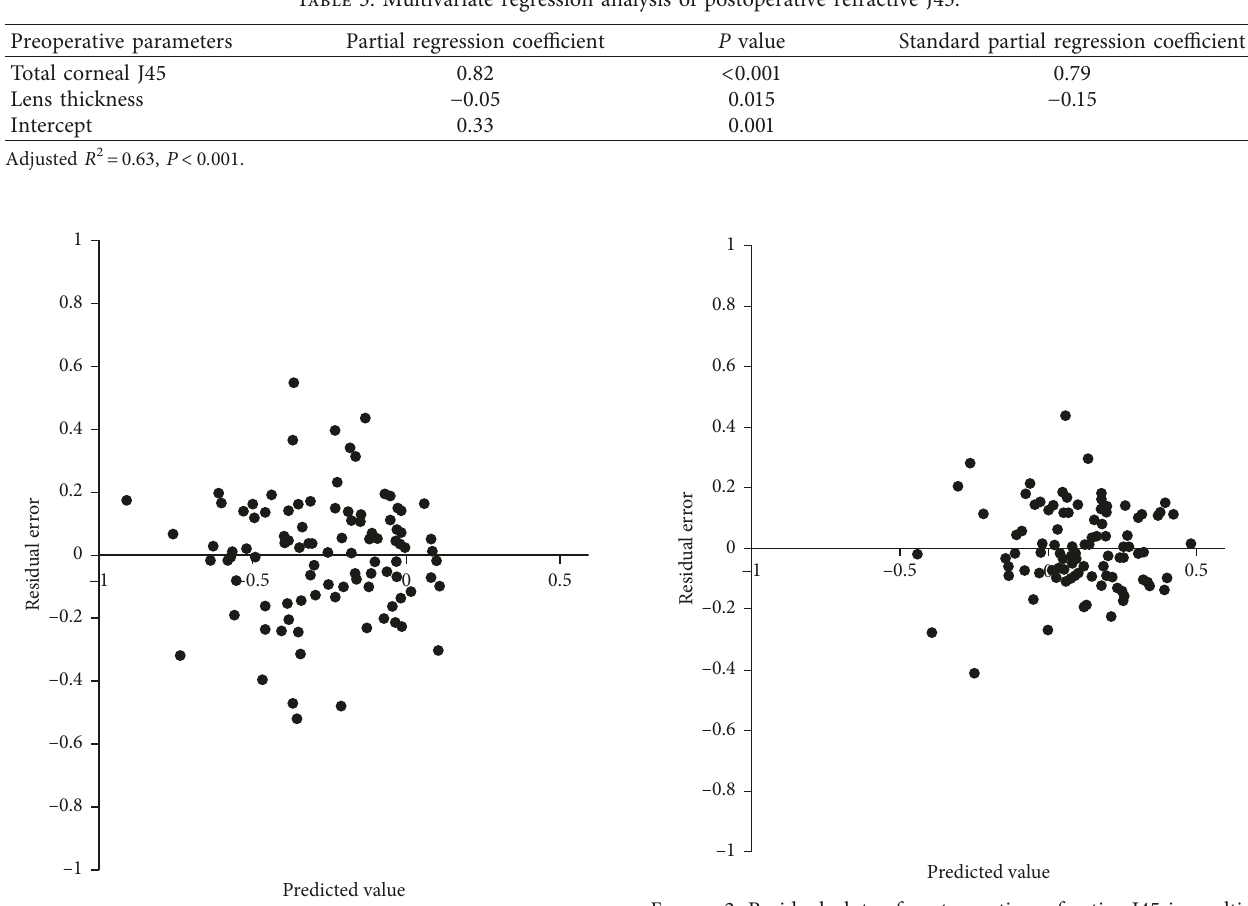
Table 3: Multivariate regression analysis of postoperative refractive J45.